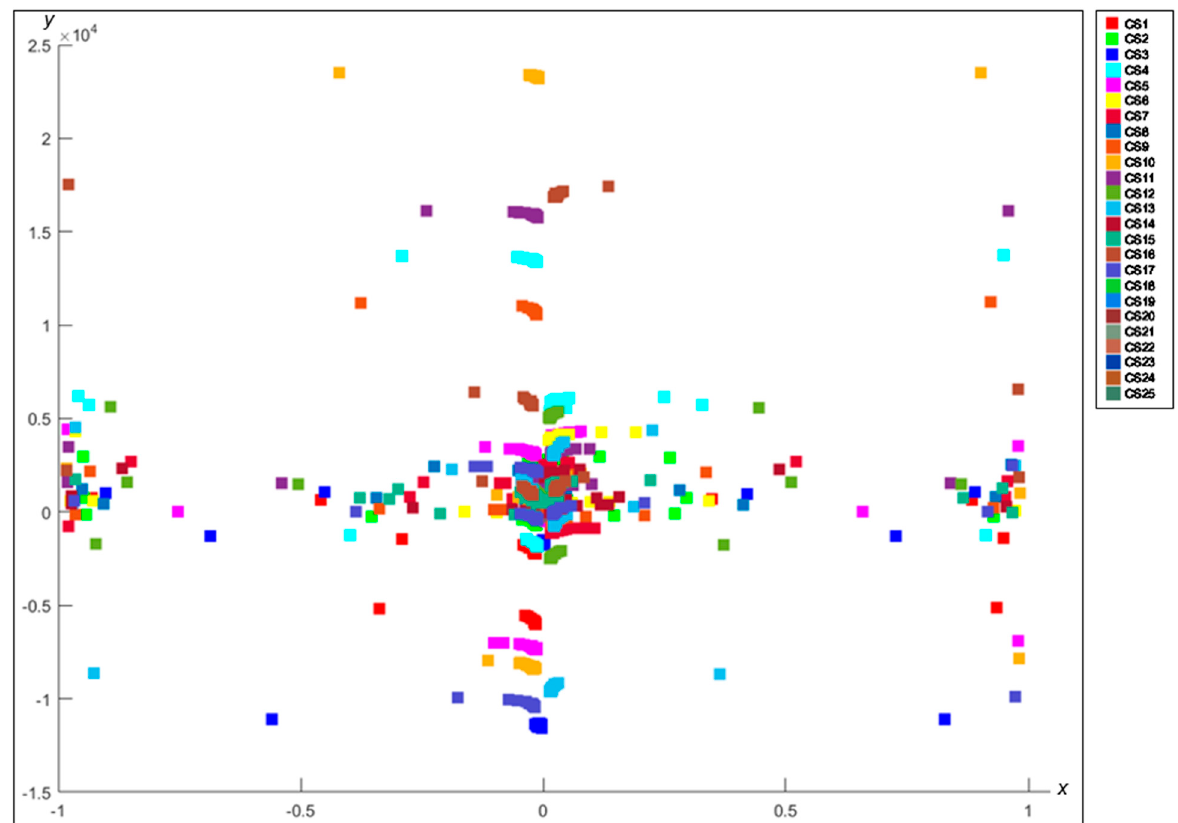
Figure 5. Coordinated FACS of counterfeit RM100.